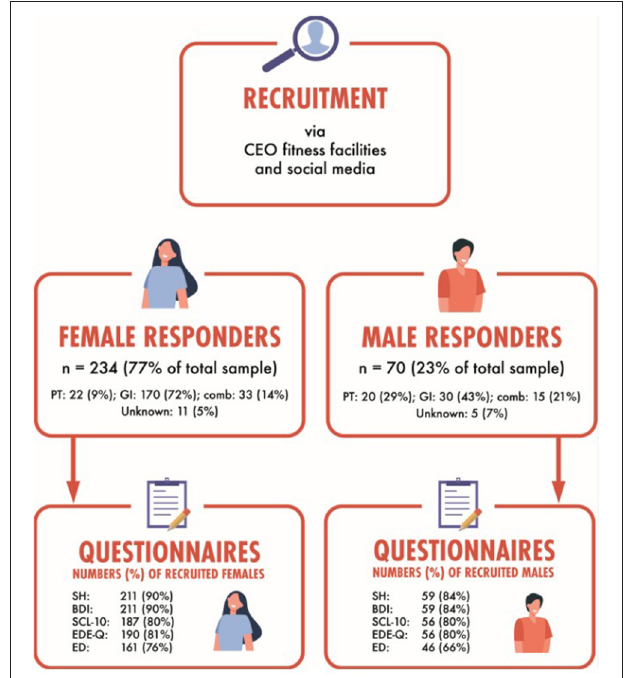
FIGURE 1 | Number of participants recruited and responding for the different questionnaires, separated by sex. CEO, chief executive officer; PT, personal trainer; GI, group instructor; comb, combined profession of PT and GI; SH, sexual harassment questionnaire; BDI, Beck Depression Inventory; SCL-10, Hopkins Symptom Checklist 10 items; EDE-q, Eating Disorder Examination Questionnaire; ED, self-reported history of eating